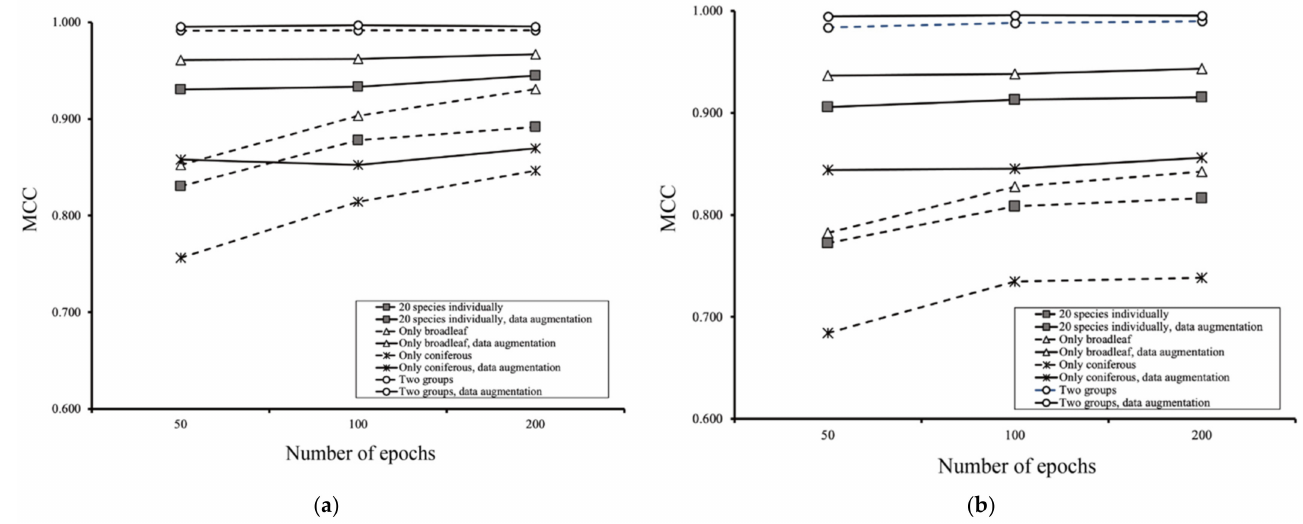
Figure 3. Classification accuracy of tree species identification for test data, based on MCC. ( a ) GoogLeNet; ( b )